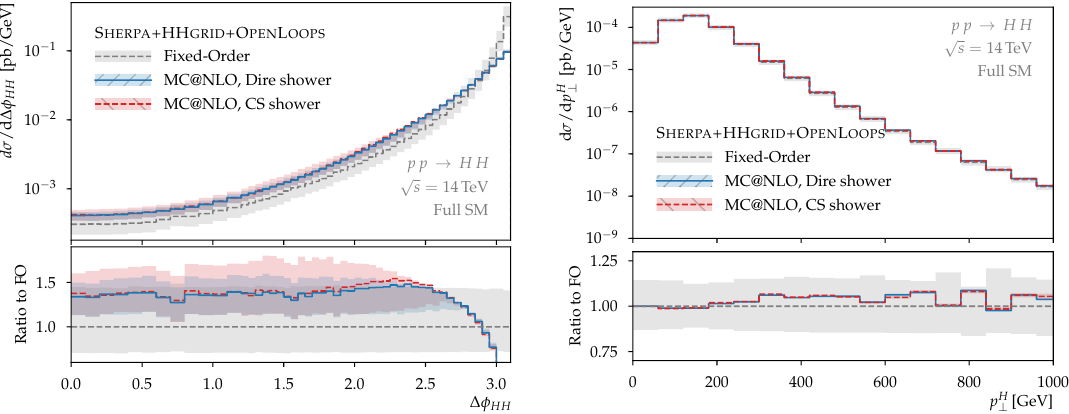
Figure 10 . Parton shower e(cid:11)ects on the azimuthal separation between the Higgs bosons (left panel) and on the transverse momentum of a randomly selected Higgs boson (right panel). The uncertainty band around the (cid:12)xed-order result is obtained through variations of (cid:22) F and (cid:22) R . Uncertainties on the MC@NLO predictions are generated by varying (cid:22) PS